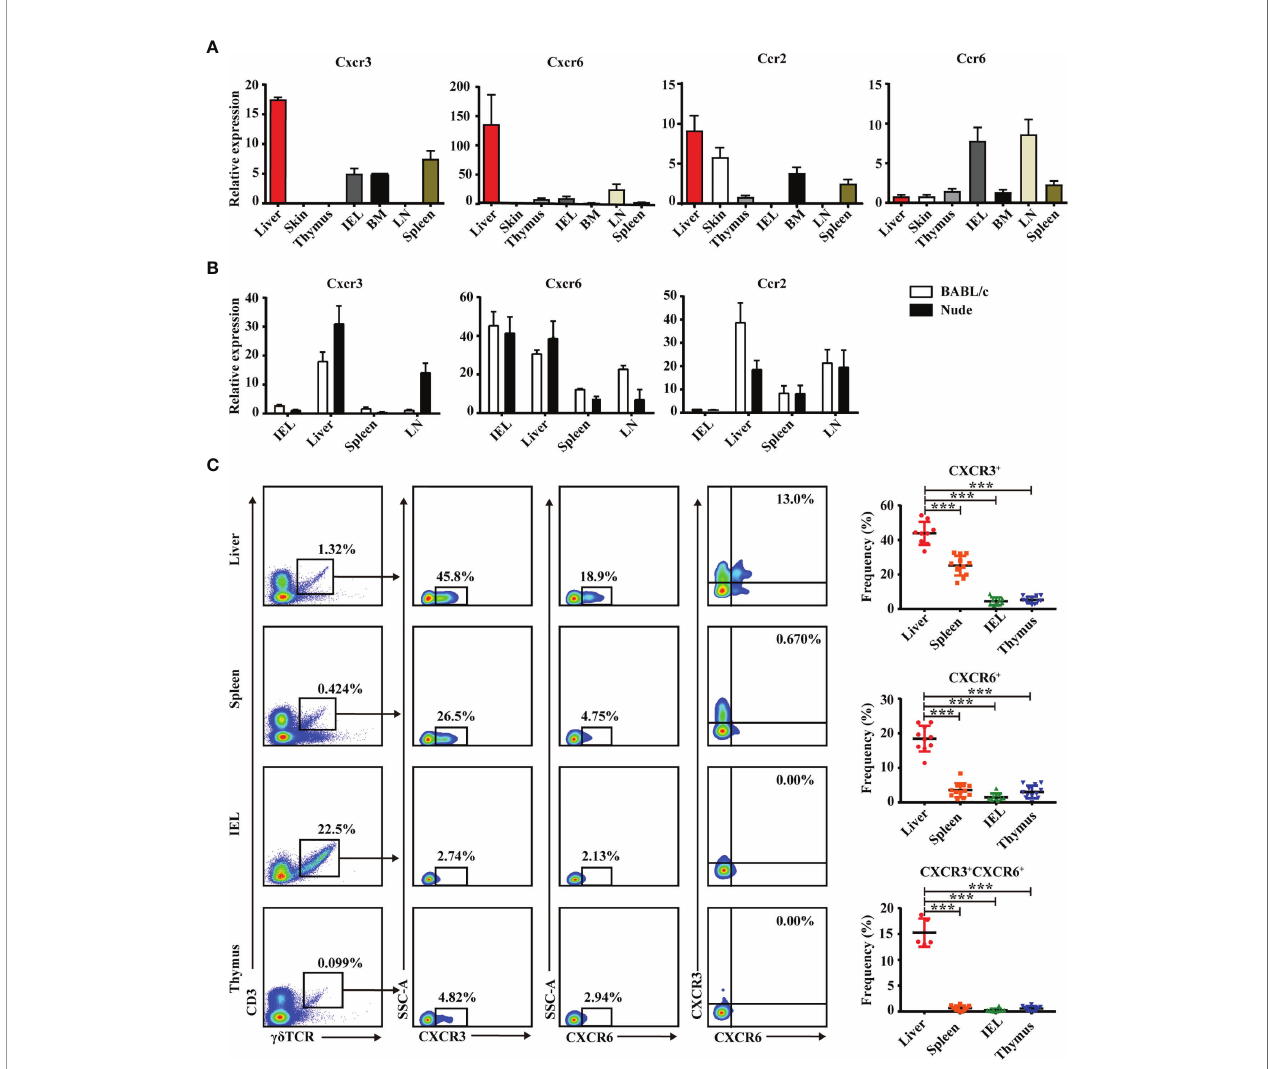
FIGURE 2 | Liver contains a speci fi c CXCR3 + CXCR6 + gd T subset. (A) CXCR3, CXCR6, CCR2, and CCR6 mRNA expression in gd T cells from indicated organs of C57BL/6J mice. (B) CXCR3, CXCR6, and CCR2 mRNA expression in gd T cells from IEL, liver, spleen, and iLN of BALB/c and nude mice. (C) Representative FACS plots and percentage of gd T cells expressing CXCR6 or CXCR3 in liver, spleen, IELs, and thymus of C57BL/6J mice. Each dot represents a mouse. Data are shown as mean ± SEM. (*** p < 0.001. One-way ANOVA with post-hoc